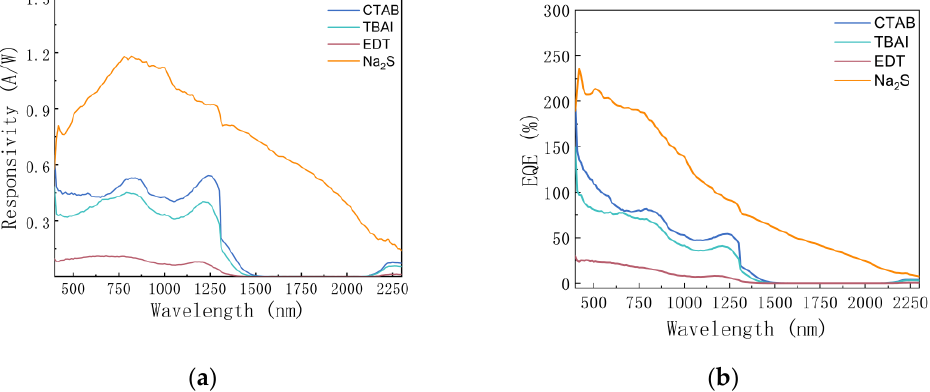
Figure 7. ( a ) The photoresponsivity (R) of the PbS QD photodetectors with the relationship of wavelength ranging from 400 nm to 2300 nm at V = 5 V; ( b ) external quantum efficiency (EQE) of the PbS QD photodetectors.